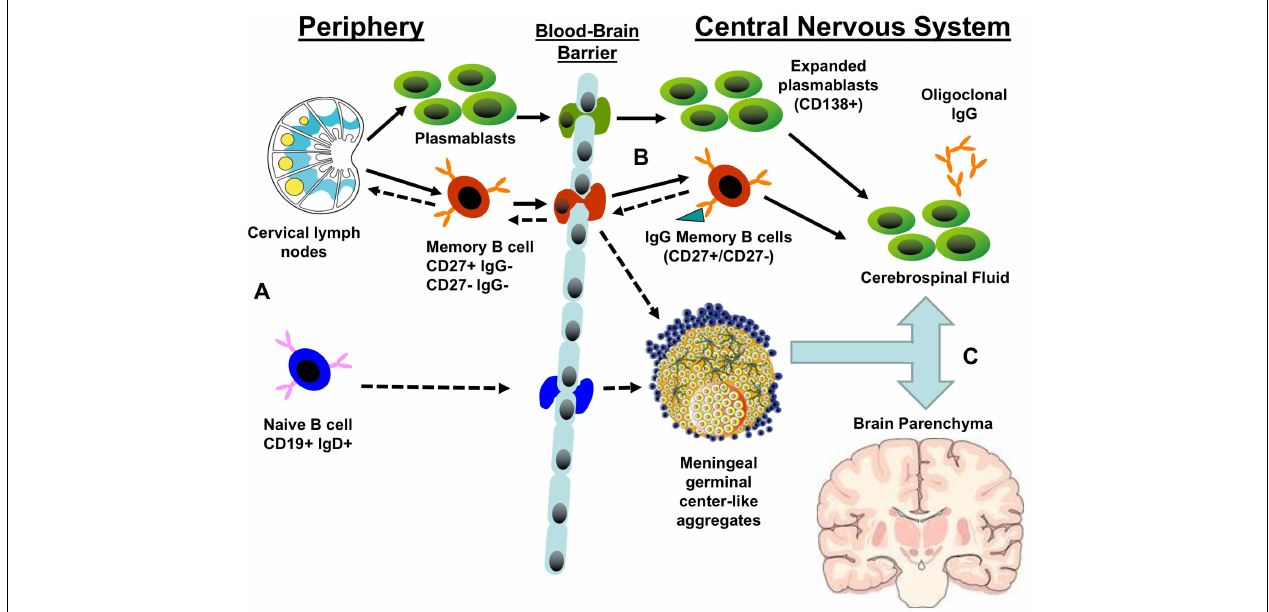
FIGURE 1 | Potential patterns of B cell trafficking in multiple sclerosis . (A) The predominant stream of migratory B cells from the periphery to the CNS are likely to consist of either memory B cells or plasmablasts produced in the germinal centers of cervical lymph nodes. The presence of CSF B cell clones closely related to germline sequences suggests that naïve B cells may transit the blood–brain barrier to populate meningeal germinal center-like structures and produce CNS-restricted memory B cells. (B) Both migratory plasmablasts and memory B cells may contribute to the pool of central nervous system (CNS) antibody-secreting cells that produce the oligoclonal bands. Memory B cells may also enter germinal centers in meningeal lymphoid aggregates or draining cervical lymph nodes, resulting in further clonal expansion and affinity maturation. (C) A significant fraction of expanded B cell clones circulates between CNS compartments: cerebrospinal fluid, meningeal lymphoid aggregates, parenchymal lesions, and normal white matter. Solid arrows represent established pathways; dashed arrows represent putative